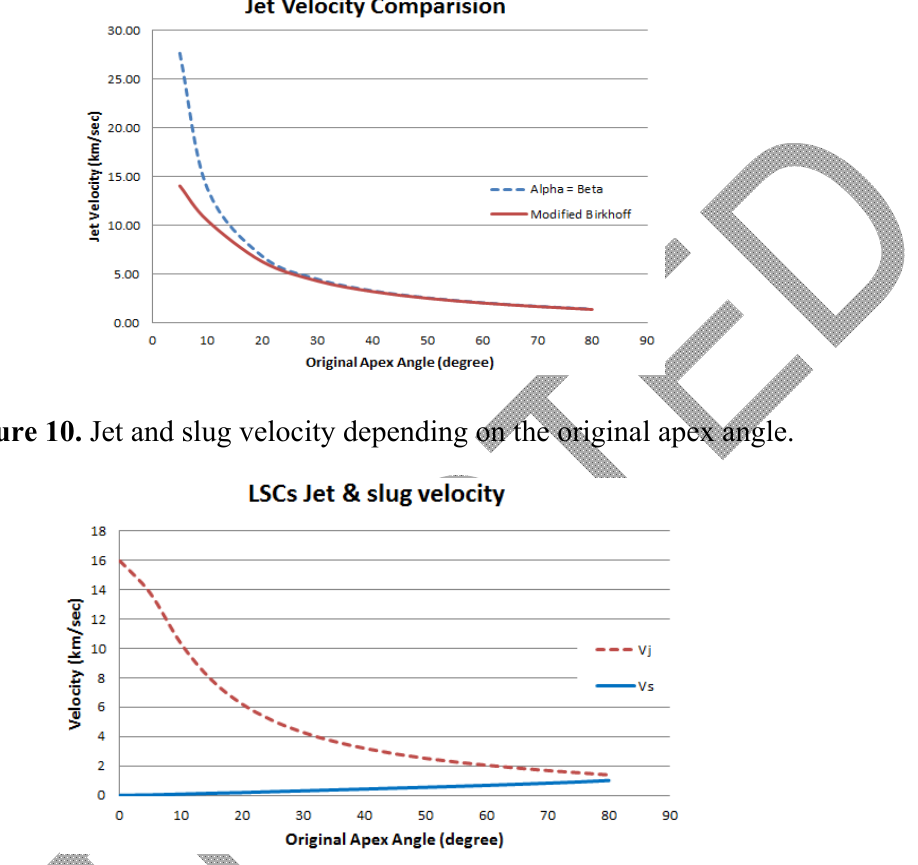
Figure 9. Comparison between α = β condition and the modified Birkhoff theory.